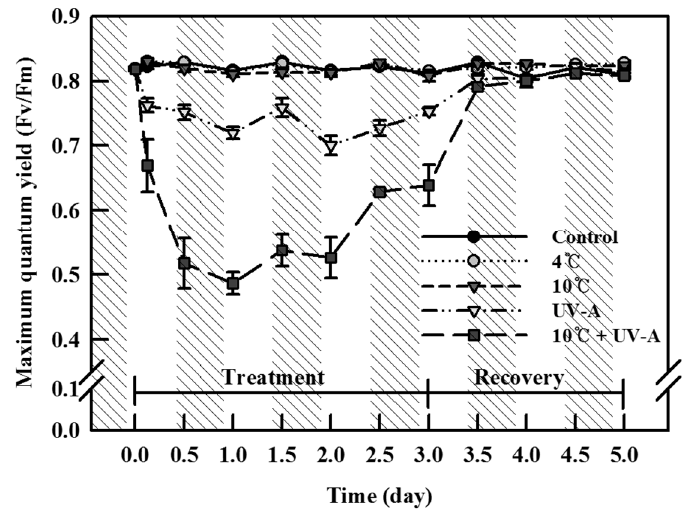
Figure 1. Maximum quantum yield ( Fv/Fm ) of kale leaves subjected to chilling (4 °C or 10 °C), UV ‐ A, and combined stress treatments (10 °C + UV ‐ A) for 3 days followed by 2 days of recovery. The vertical bars indicate standard errors ( n = 9). Slashes indicate nighttime (0.5 day).